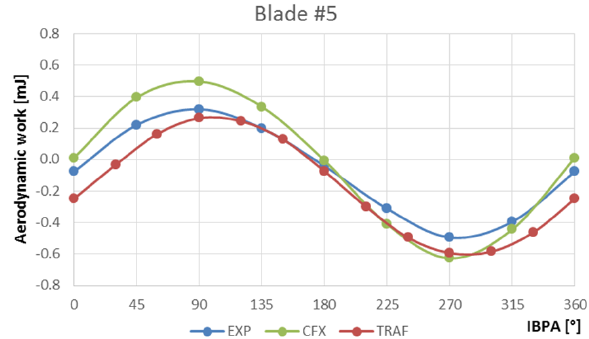
Figure 19. Aerodynamic work of blade torsion mo- tion - blade #3: experimental (EXP), CFX and TRAF comparison.